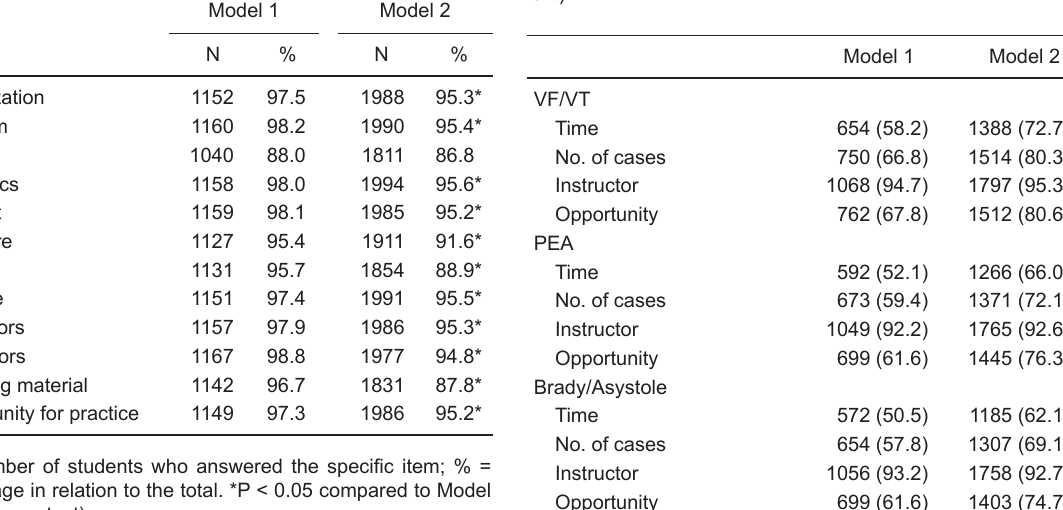
Table 2. Overall course evaluation according to course model. Table 3. Evaluation of practice station, with number of students who received a score of 5 on a scale from 1 (poor) to 5 (excel -